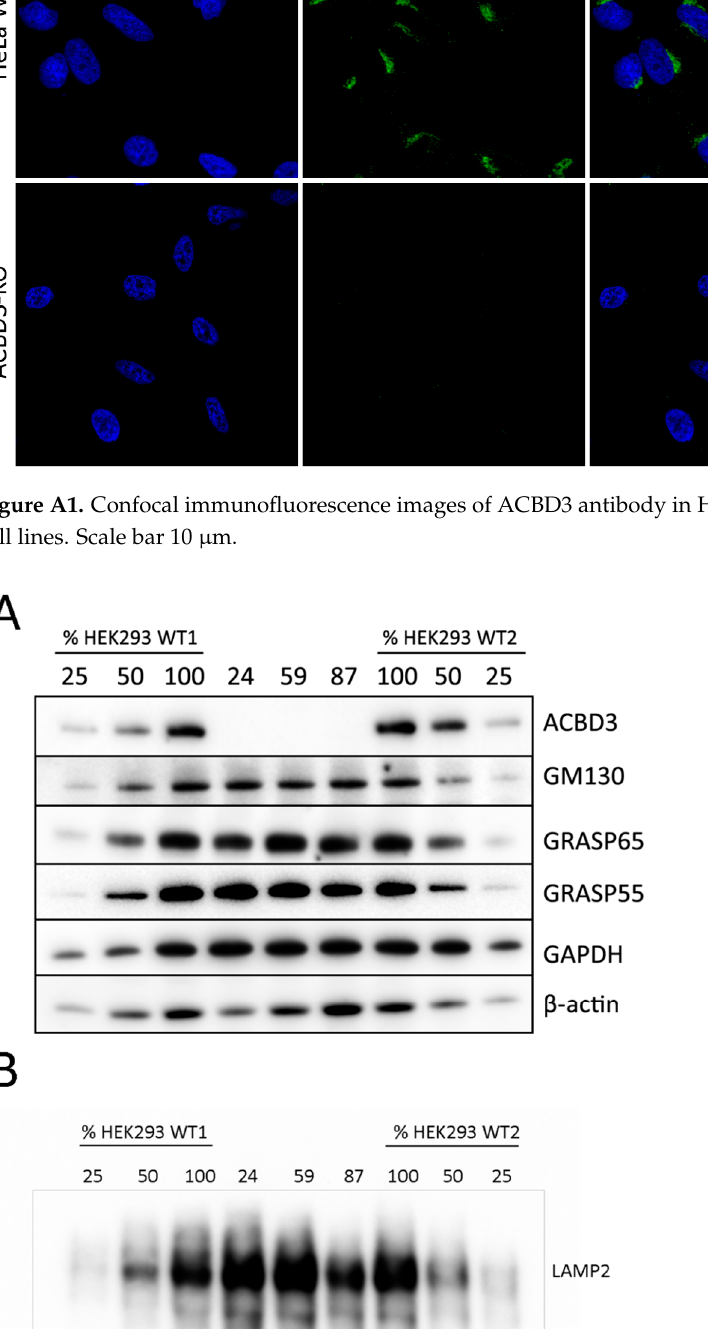
Figure A3. Quantification of Western blots from Figure 4. ( A ) BN-PAGE/WB of HEK293 ACBD3-KO, ( B ) BN-PAGE/WB of HeLa ACBD3-KO, ( C ) SDS-PAGE/WB of HEK293 ACBD3-KO, and ( D ) SDS-PAGE/WB of HeLa ACBD3-KO. ‘n’ represents number of independent analyses per sample.